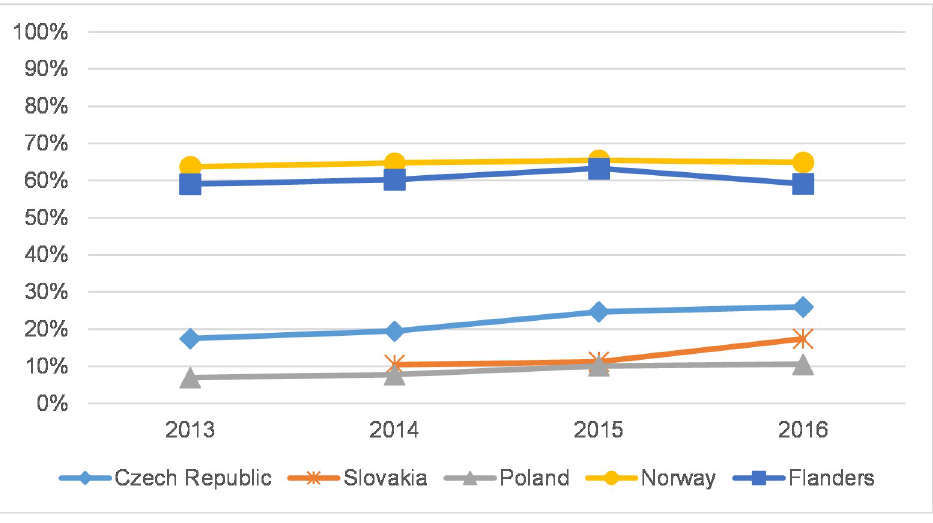
Fig 3. Coverage of journal articles in WoS–social